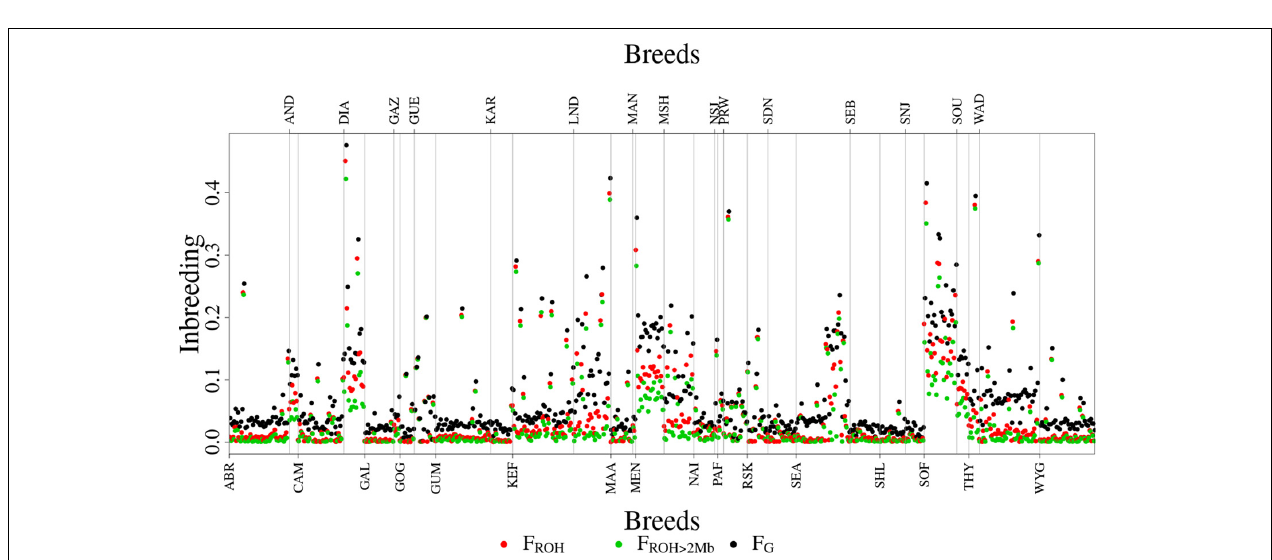
FIGURE 6 | Distribution of the inbreeding metrics (F G , F ROH , and F ROH > 2Mb ) for all the 608 animals by breed.